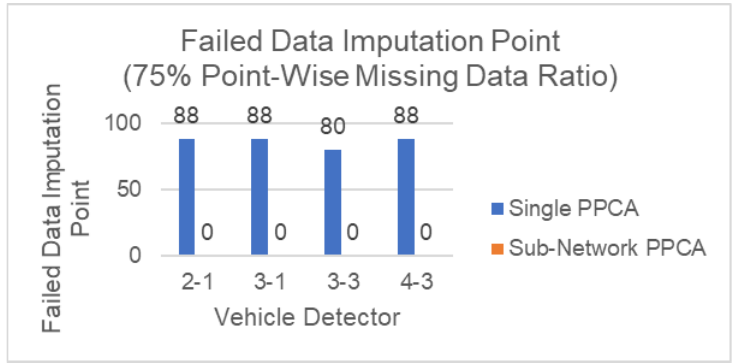
Figure 10. Failed data imputation points for in Scenario B for 75% point-wise missing data ratio. ISPRS Int. J. Geo-Inf. 2022 , 11 , x FOR PEER REVIEW